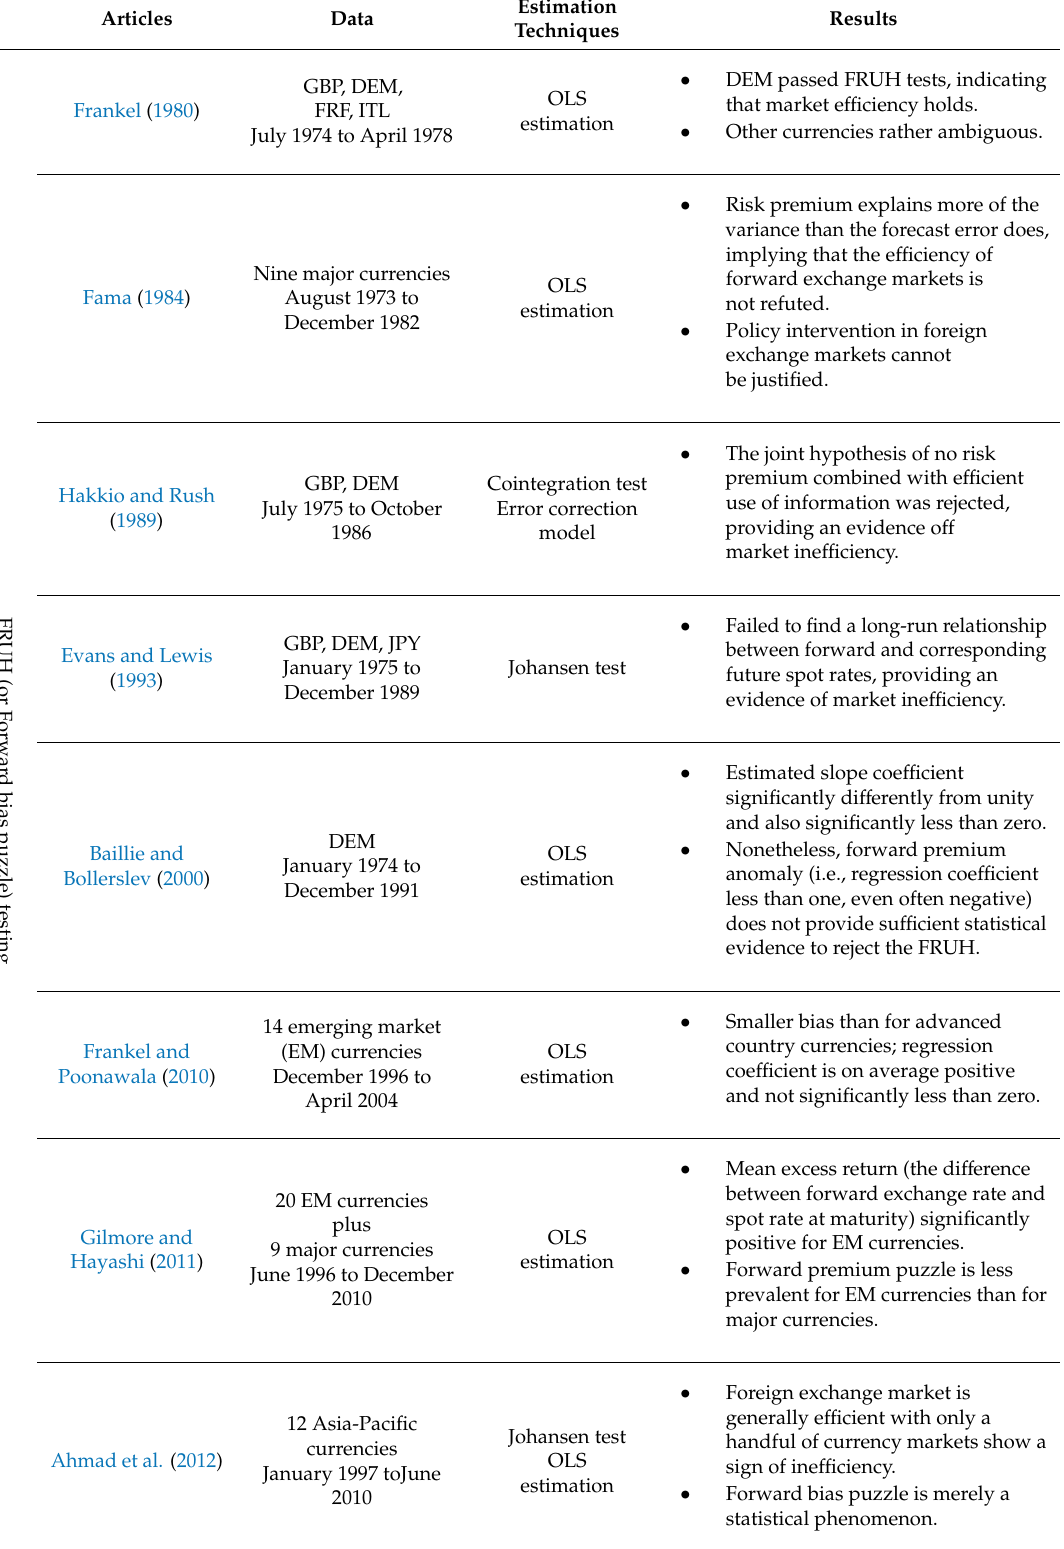
Table 1. Some selected works on the foreign exchange market e ffi